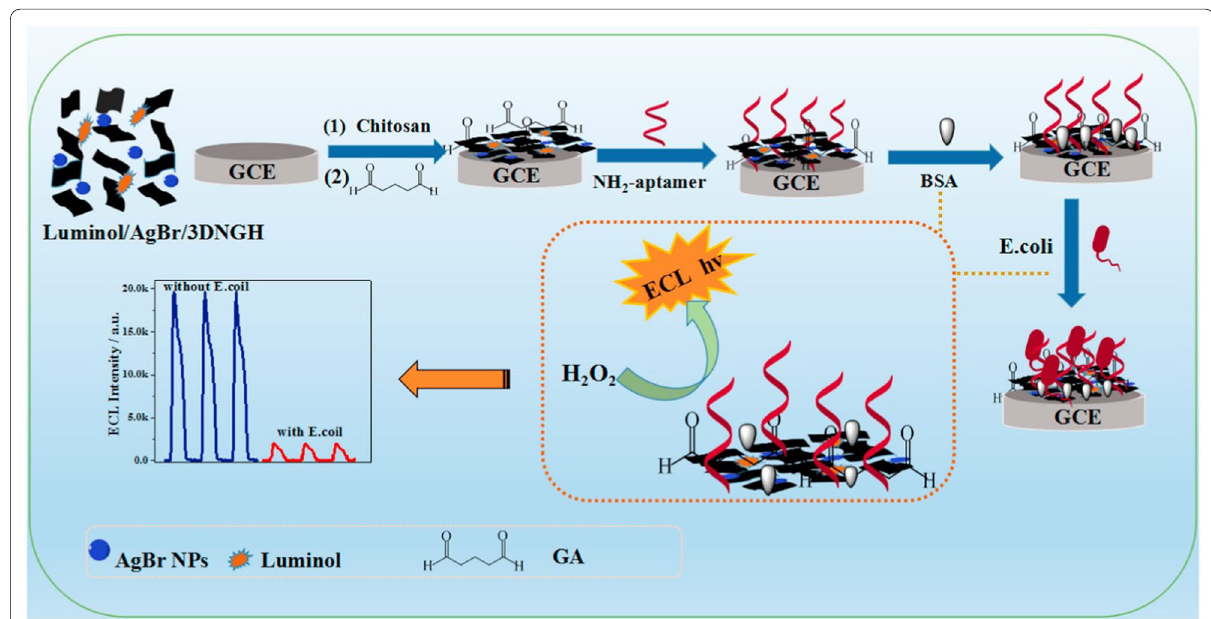
Fig. 17 The schematic presentation for the ECL Escherichia coli biosensor fabricated with luminol/AgBr/3DNGH. Adapted from Ref. [147] with permission. Copyright (2017) Biosensors and